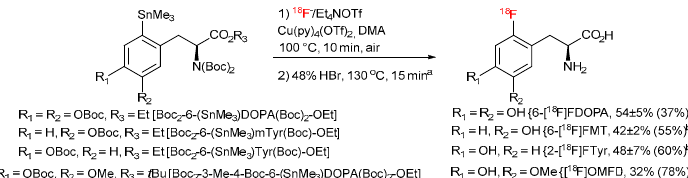
Figure 13. Preparation of N , N -diBoc protected radiolabeling precursors.